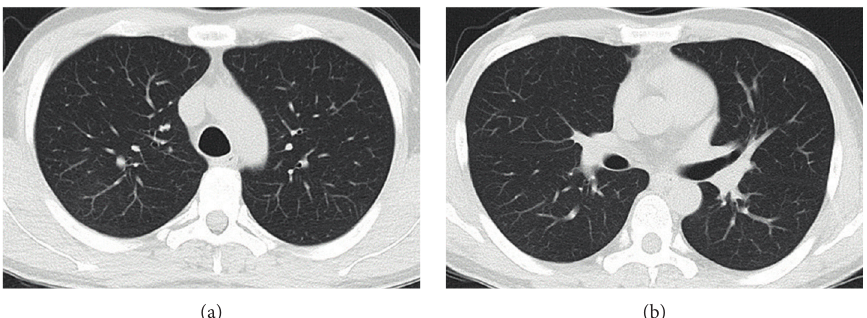
Figure 4: Postoperative chest computed tomography (CT) radiological findings. A chest CT in the lung window setting showed no consolidation or ground-glass